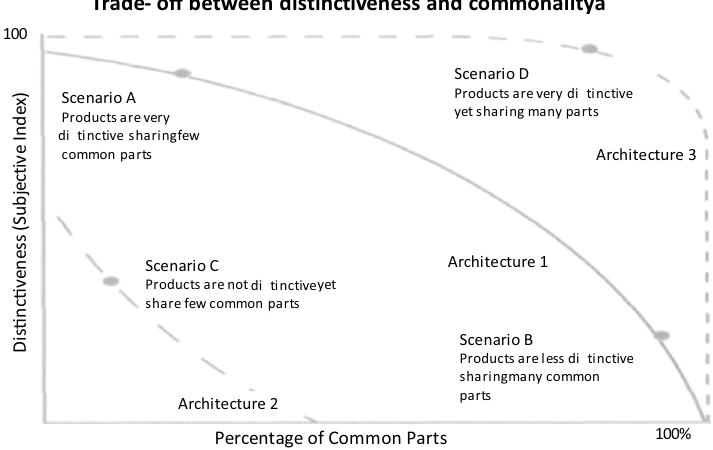
Figure 1. Trade-off between differentiation and commonality (reference: